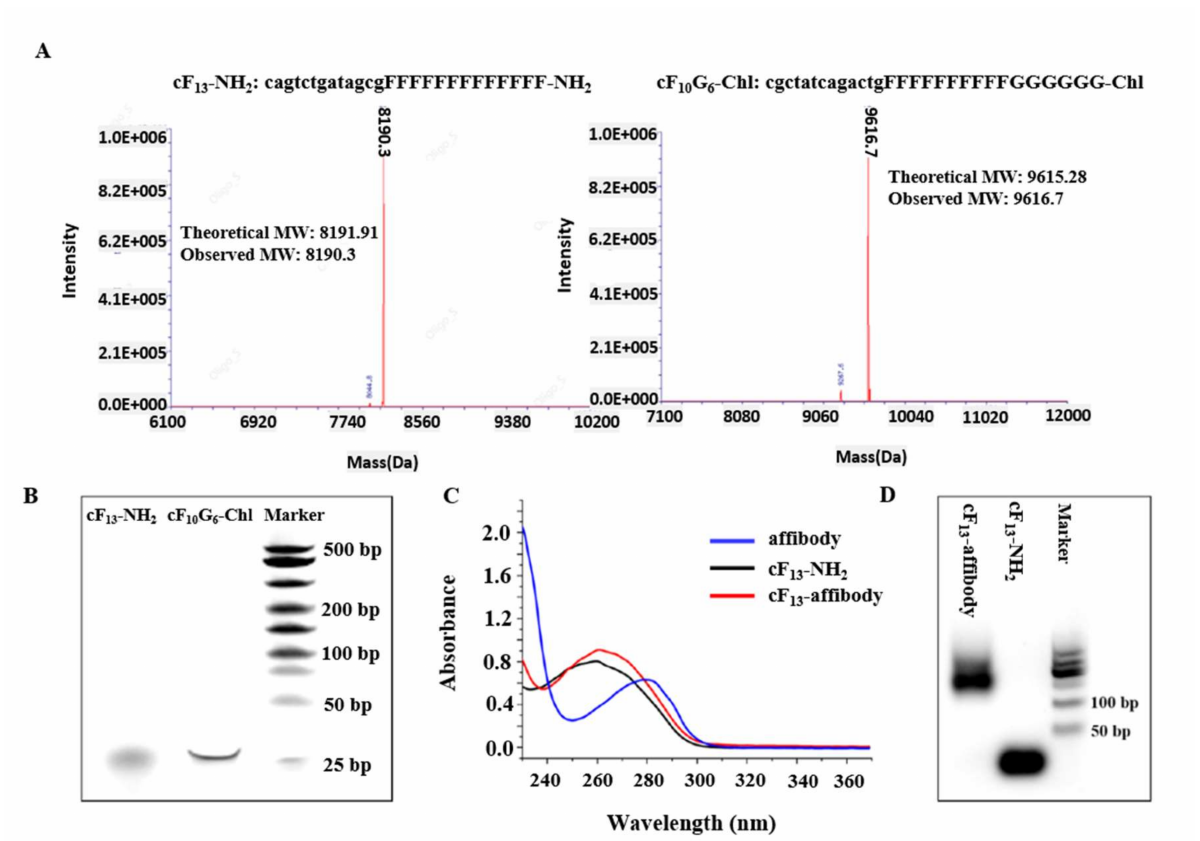
Figure 1. ( A ) Mass spectrometry of cF 13 -NH 2 , cF 10 G 6 -Chl. ( B ) cF 13 -NH 2 and cF 10 G 6 -Chl were assayed by 10% denaturing polyacrylamide gel. ( C ) UV-vis analysis of affibody, cF 13 -NH 2 and cF 13 -affibody. ( D ) cF 13 -NH 2 and cF 13 -affibody were assayed by 2% agarose